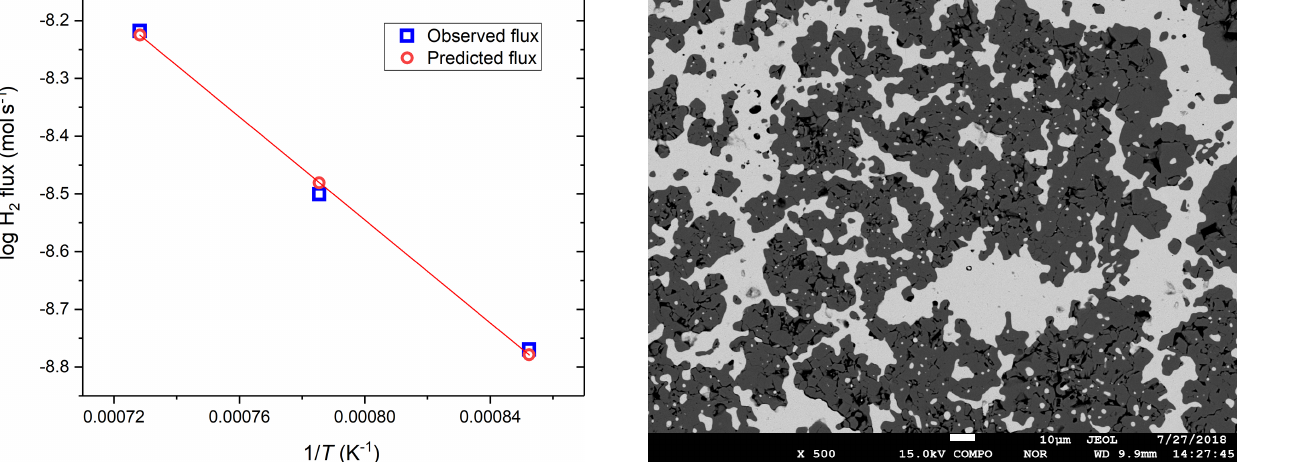
Figure 5. Comparison of the observed flux calculated from the pri- mary data shown in Fig. 2 and the flux predicted by substituting the optimized A and B values into Eq. (4) to calculate the permeability constants for the MHC alloy. The plotted flux values are for an f H 2 gradient of 10.19bar.